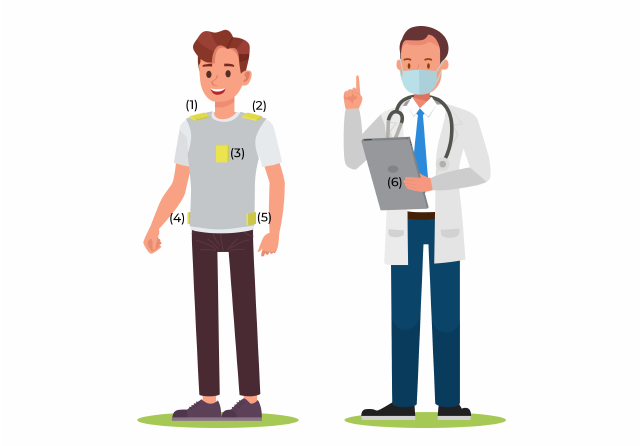
Figure 1. Visual description of the GPSJack technology and application